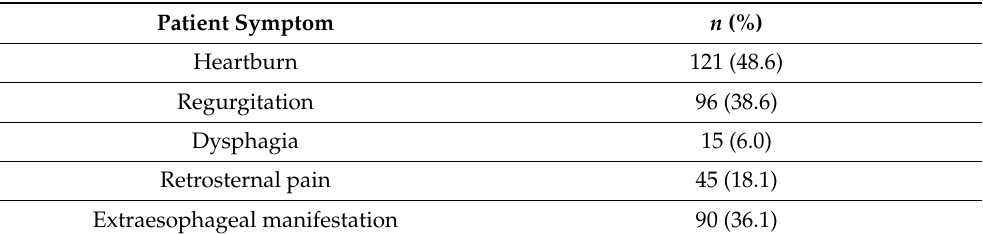
Table 1. Patients’